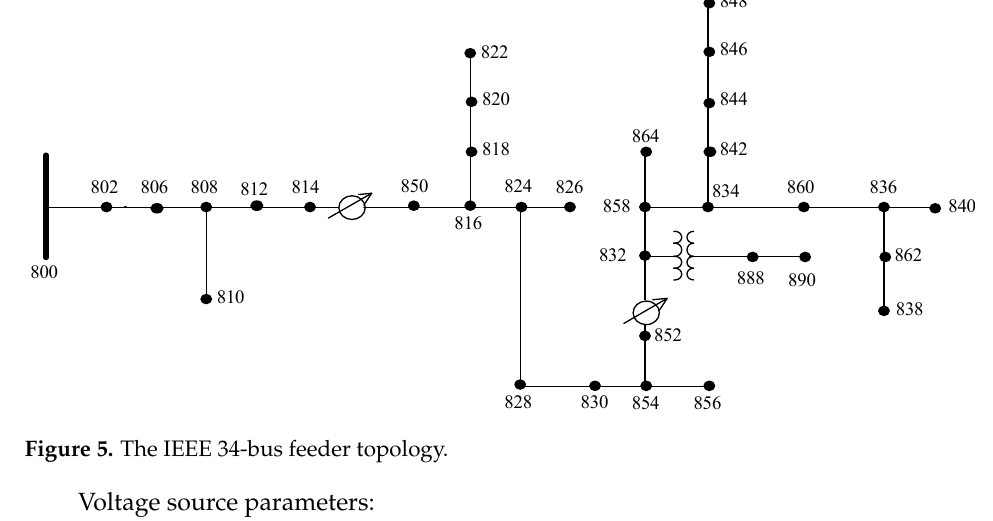
Figure 5. The IEEE 34-bus feeder topology.